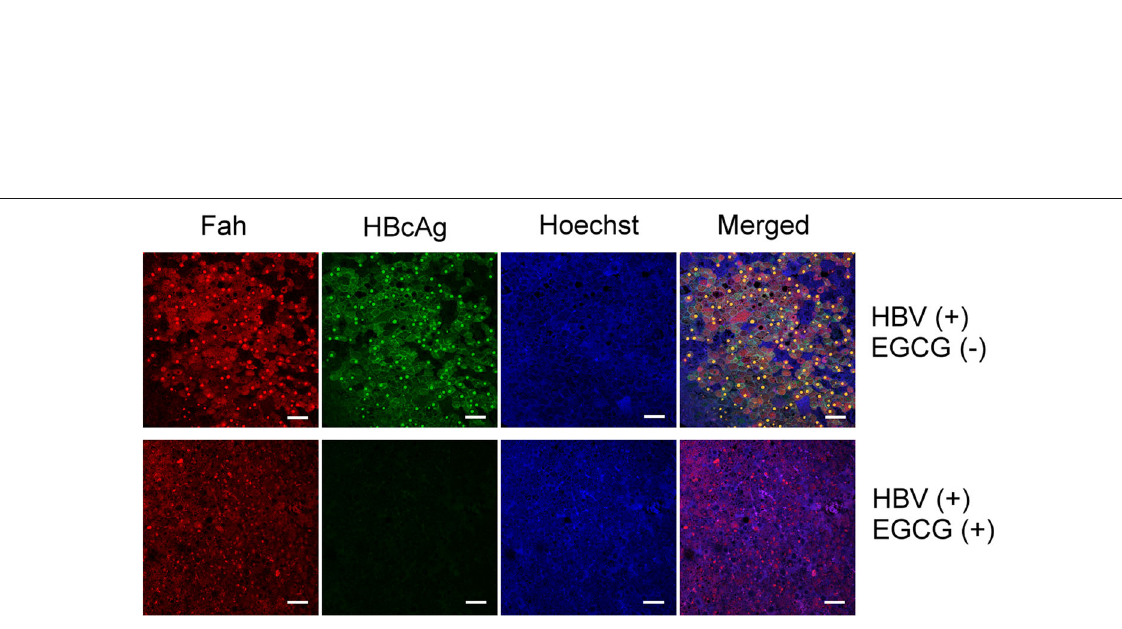
Fig. 5 Expression of Fah and HBcAg in the livers of human chimeric mice. Expression of Fah and HBcAg were examined by immunofluorescence staining with antibodies against Fah and HBcAg, followed by confocal microscopy. The bars on the images represent 100 μ